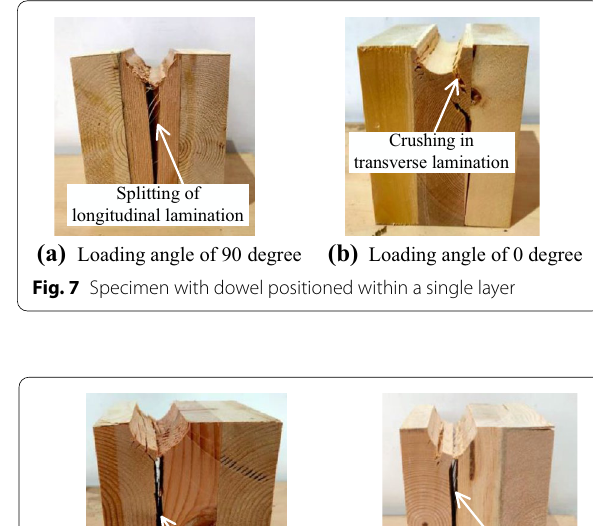
Crack in transverse lamination